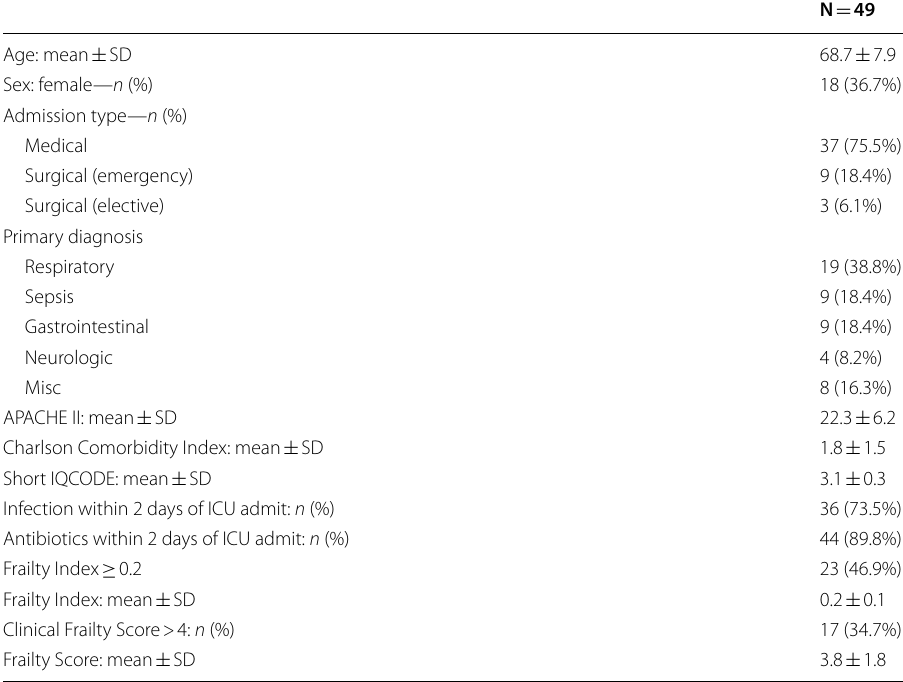
Table 2 Frailty characterization on ICU admission and hospital discharge